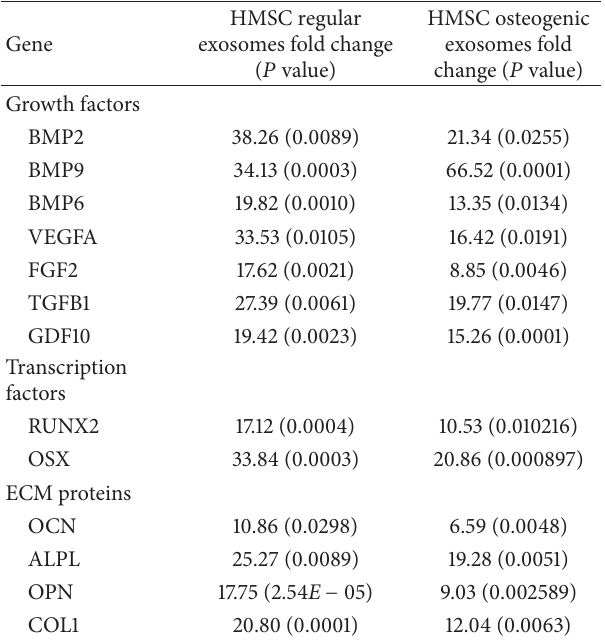
Table 4: Four-week exosome mediated change in gene expression: 3D HMSC